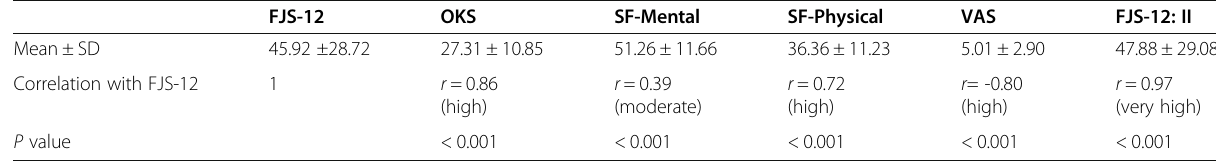
Table 3 Mean scores and correlations with commonly-used patient-reported outcome